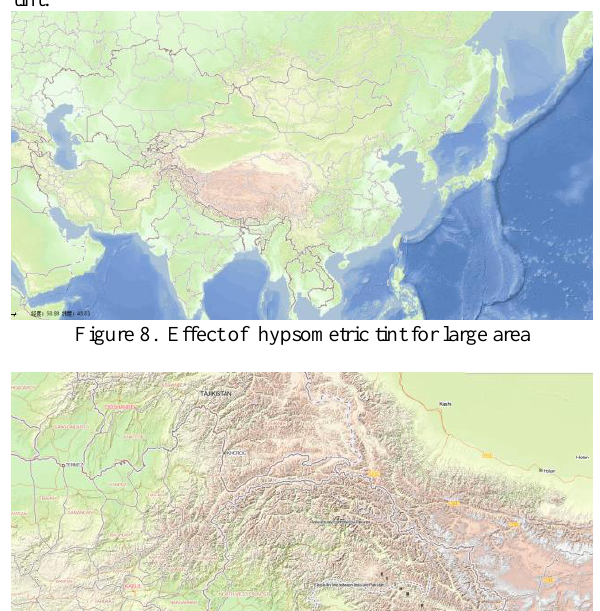
Figure 10. Effect of tile cache on